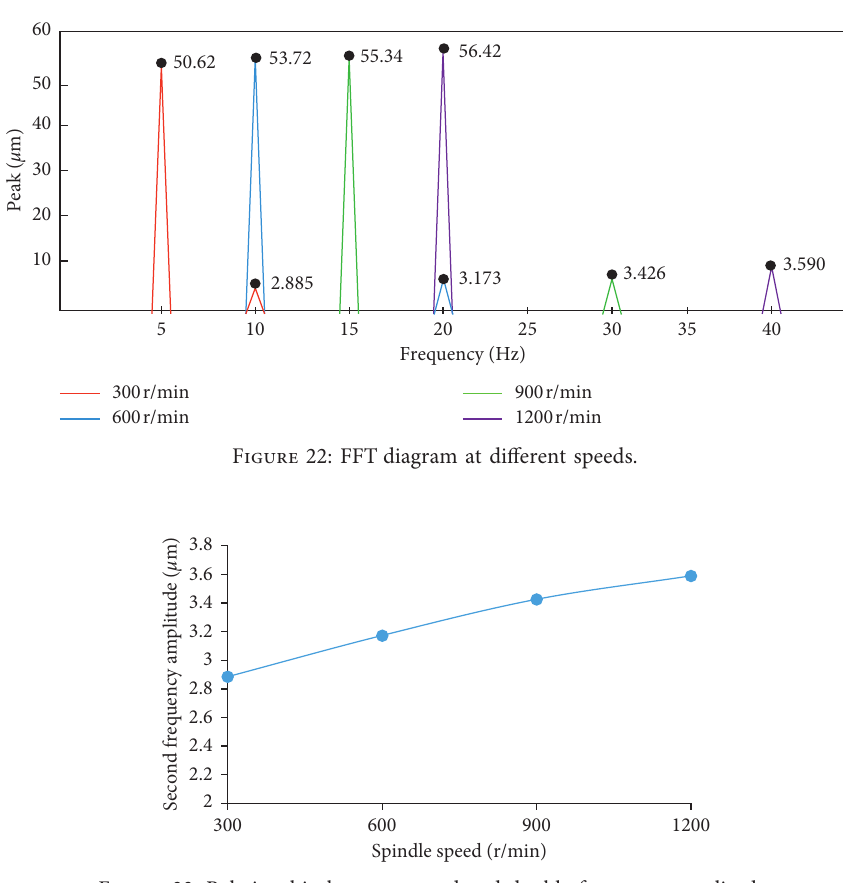
Figure 23: Relationship between speed and double frequency